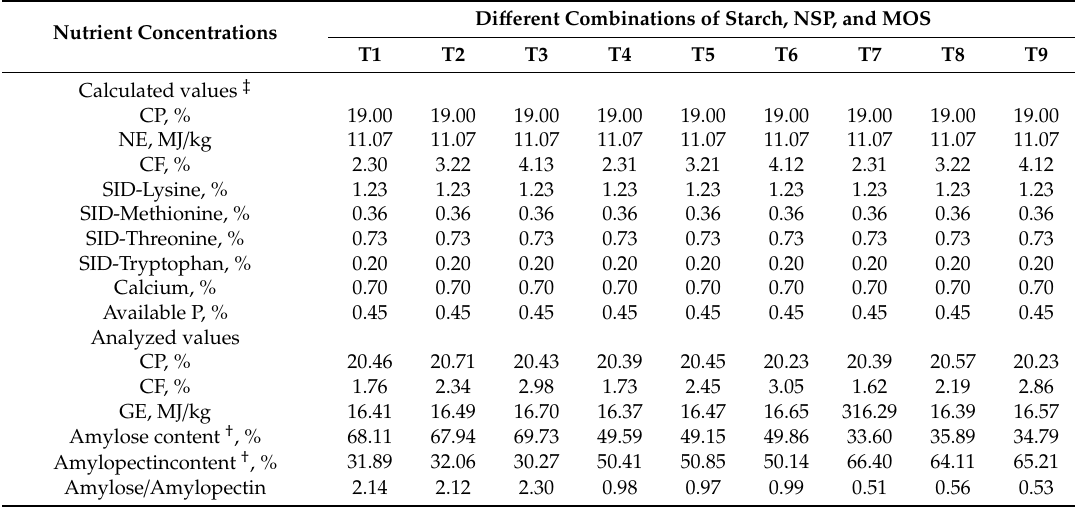
Table 3. Calculated and analyzed nutritional content of experimental diets (as-fed